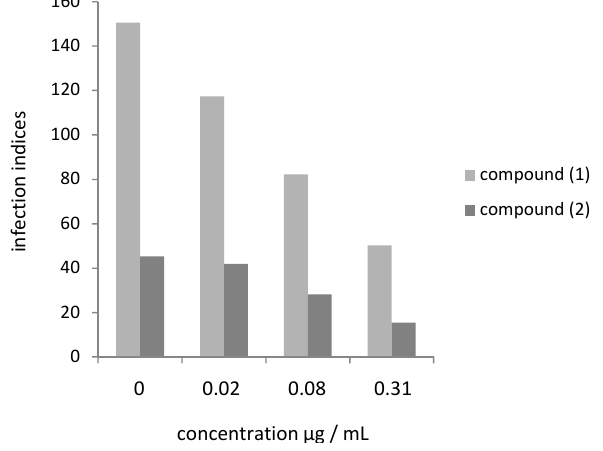
Figure 3. Effect of compounds 1 and 2 on L. chagasi infection of peritoneal BALB/c